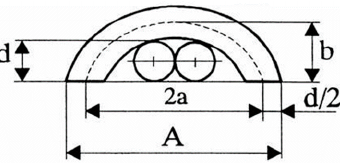
Figure 1. Geometrical model of the loop head by ˇCiukas (here d —yarn diameter; A —wale spacing; Figure 2. Geometrical model of the loop head by Č iukas (here d —yarn diameter; A —wale spacing; a —large radius of ellipse; b —small radius of ellipse), a – large radius of ellipse; b – small radius of ellipse), (mm).